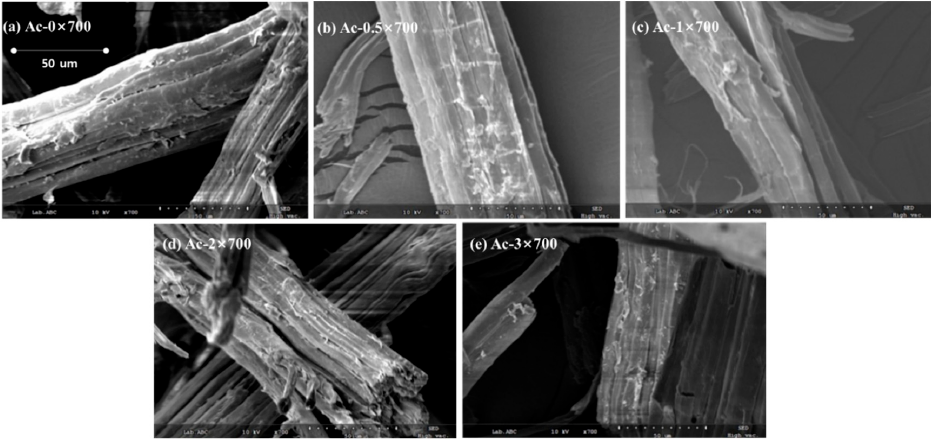
Figure 2. Scanning Electron Microscopy (SEM) micrographs of kenaf with different acetylation reaction times.